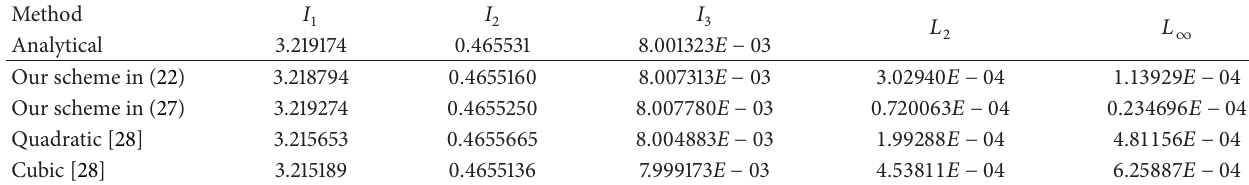
Table 3: Invariants and error norms for single solitary wave, 𝑐 = 0.05 , ℎ = 0.2 , 𝑘 = 0.2 , 𝑥 0 = 40 , 0 ≤ 𝑥 ≤ 100 , and time = 10. Method